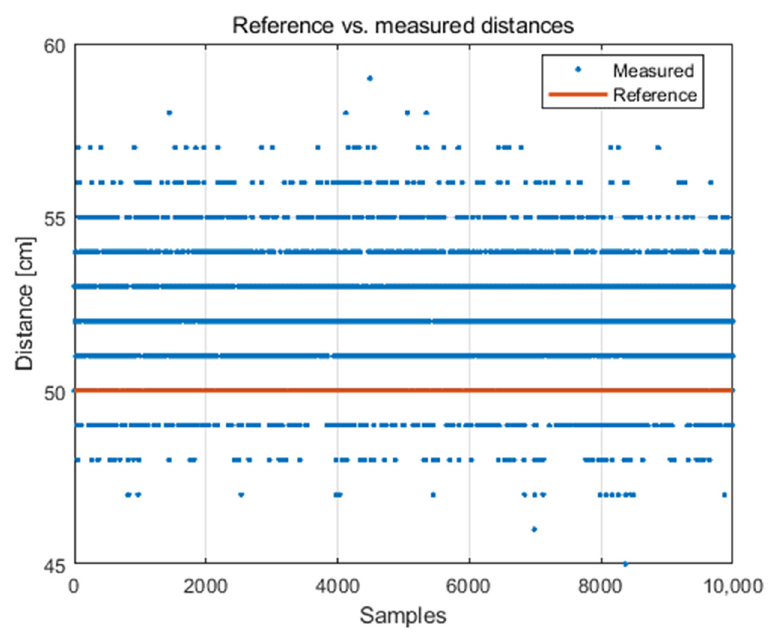
Figure 3. System readings (determined distances) for 50 cm distance between nodes. The collected statistical measures relating only to the distance measurement under LOS conditions are presented in Table 2. The mean values (d mean ) are close to the median value (d med ), which indicates a relatively symmetrical concentration of the measurements around the mean. The difference is presented in Figure 4. The maximum absolute value of the difference between the mean value and the median value (|d mean − d med |) is 0.6 cm (for the distance of 20 m). Table 2. Statistical measures of the distance under LOS conditions.